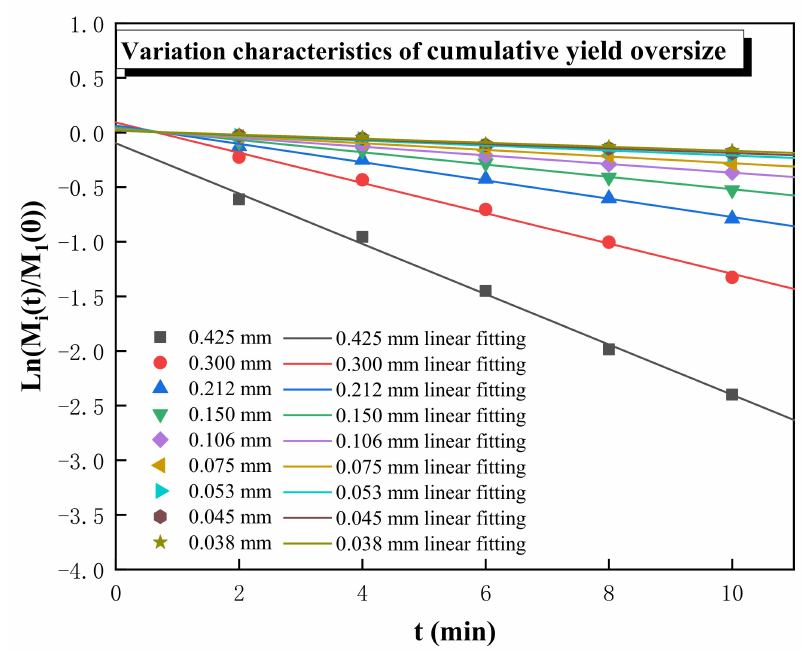
Figure 6. Variation characteristics of cumulative yield oversize in discharge. Table 5. The fitting equation and linear fit correlation coefficient R 2 of ln[M i (t)]/M 1 (0)] −